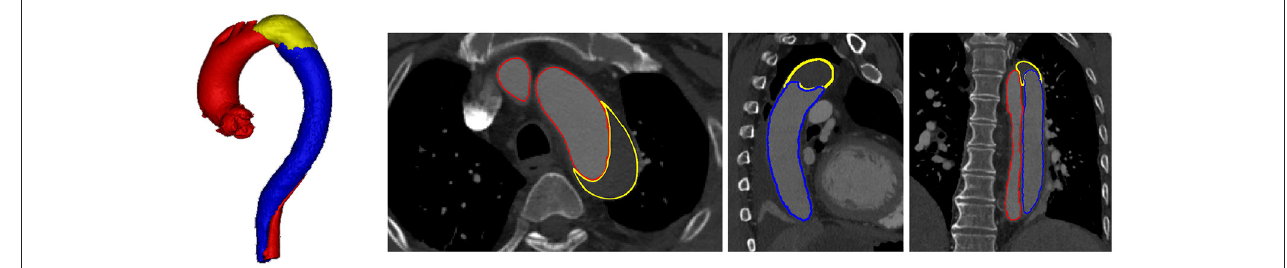
FIGURE 1 | Visualization of TBAD in a 3D model including FLT (yellow), TL (red), and FL (blue), and the corresponding CTA image with axial, coronal, and sagittal